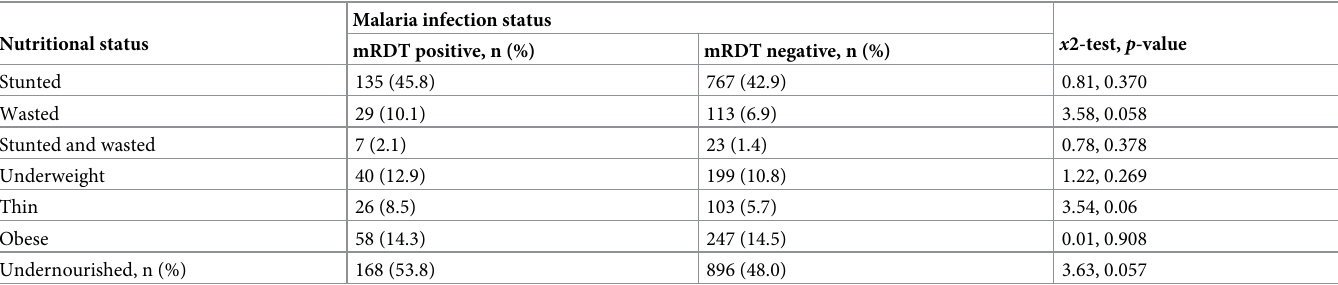
Table 4. Nutritional status in relation to malaria